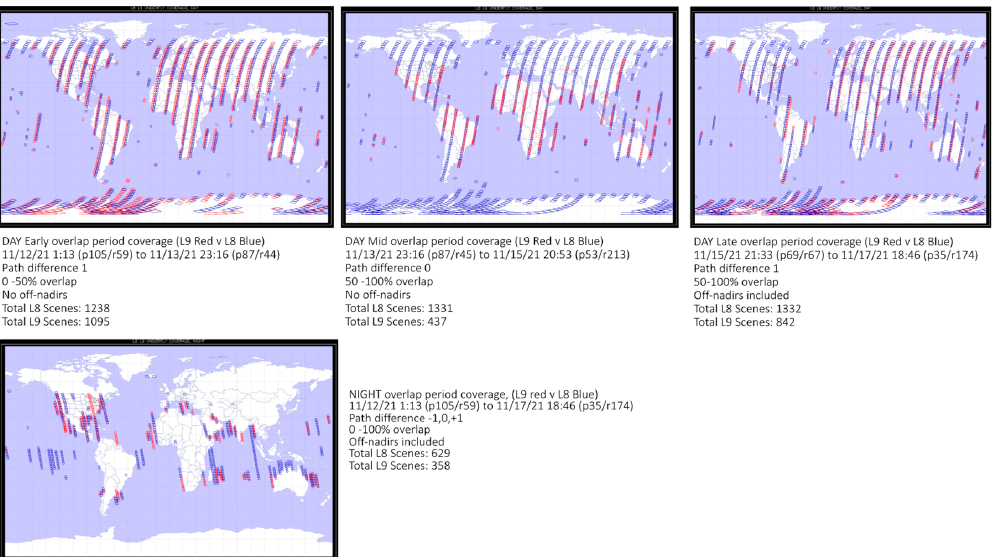
Figure 9. Landsat 9 and Landsat 8 Path(P)/Rows(R) Acquired During the Tandem flying (Day and Night).